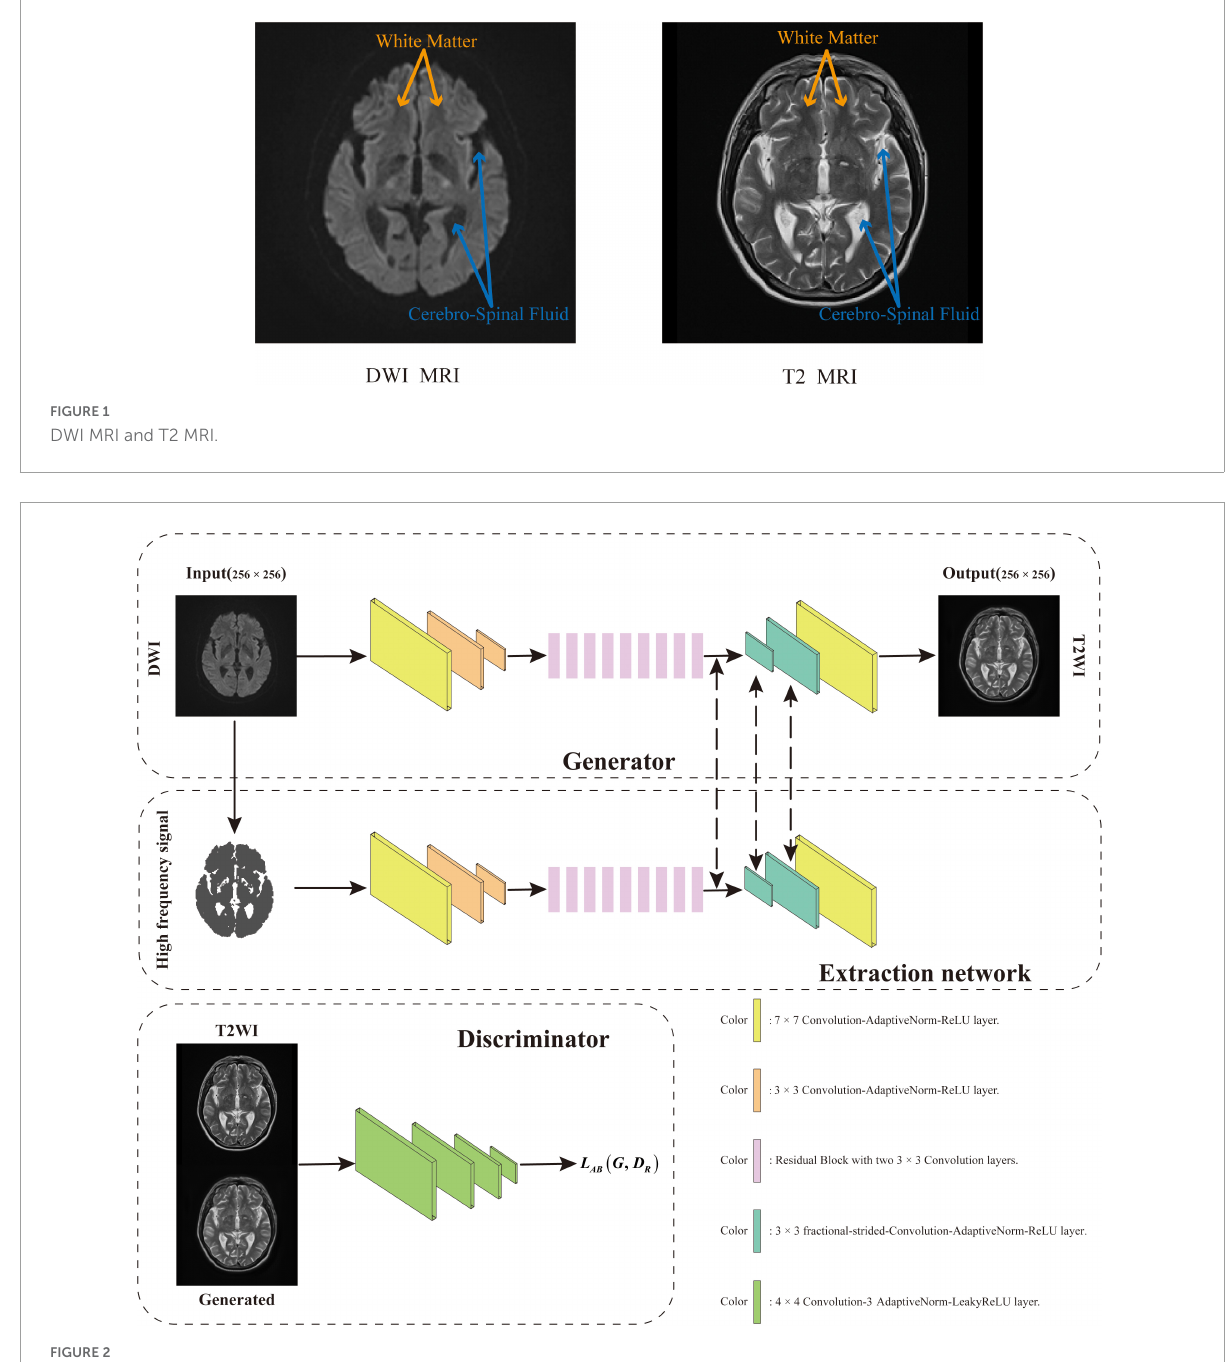
FIGURE2 AN-GAN framework design consists of three parts, namely, generator, extraction network, and